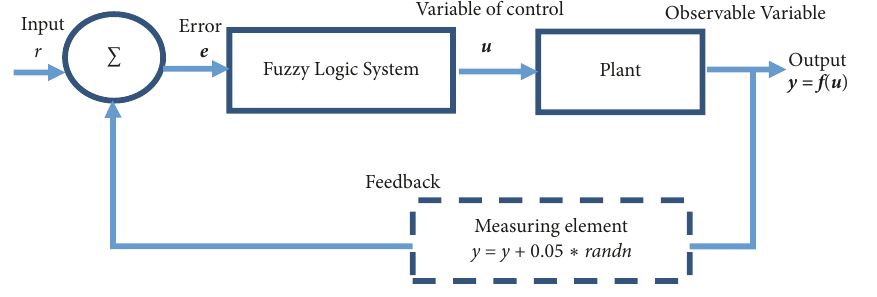
Figure 1: General representation of a